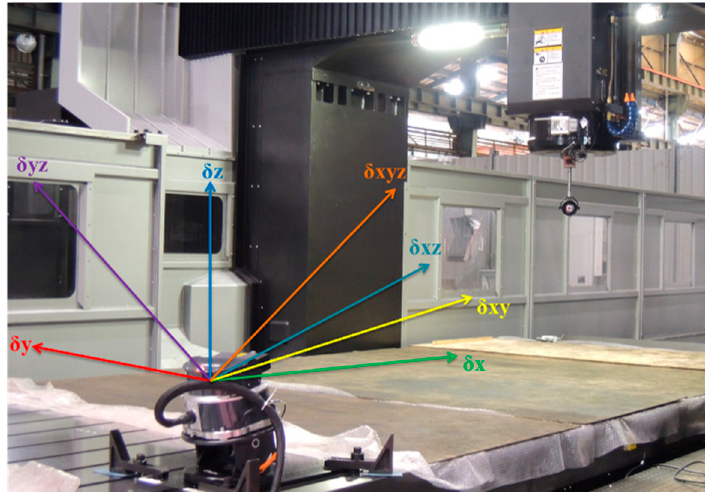
Figure 8. Illustration of the positioning accuracy and repeatability test according to ISO 230-2 and-6 for machine tools.